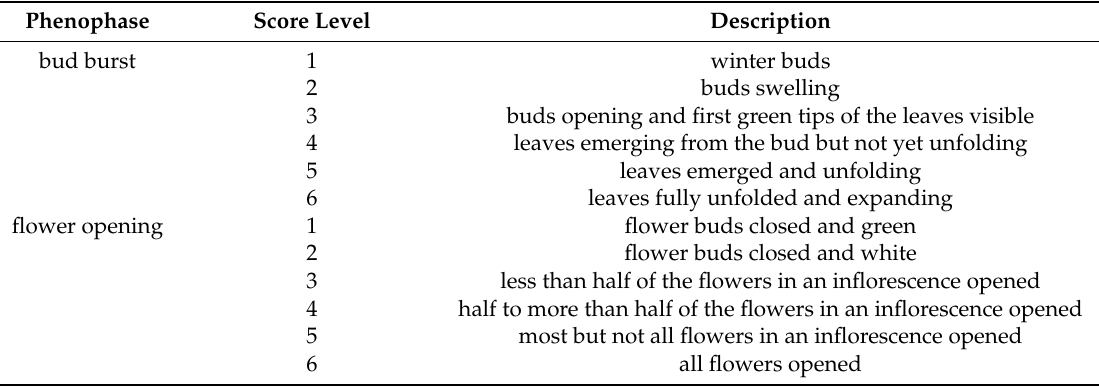
Table 2. Description of the different score levels of the four observed phenophases.